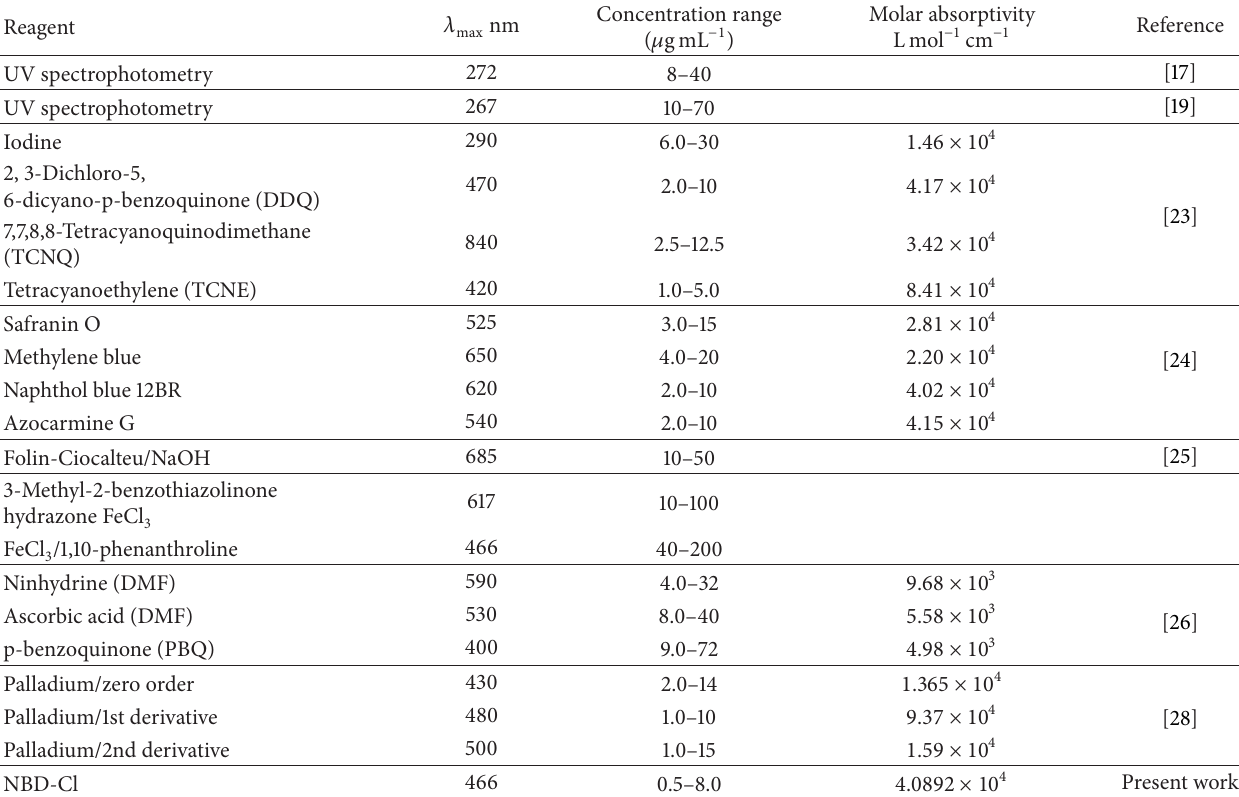
Table 1: Comparison between the reported spectrophotometric methods for determination of GMF.